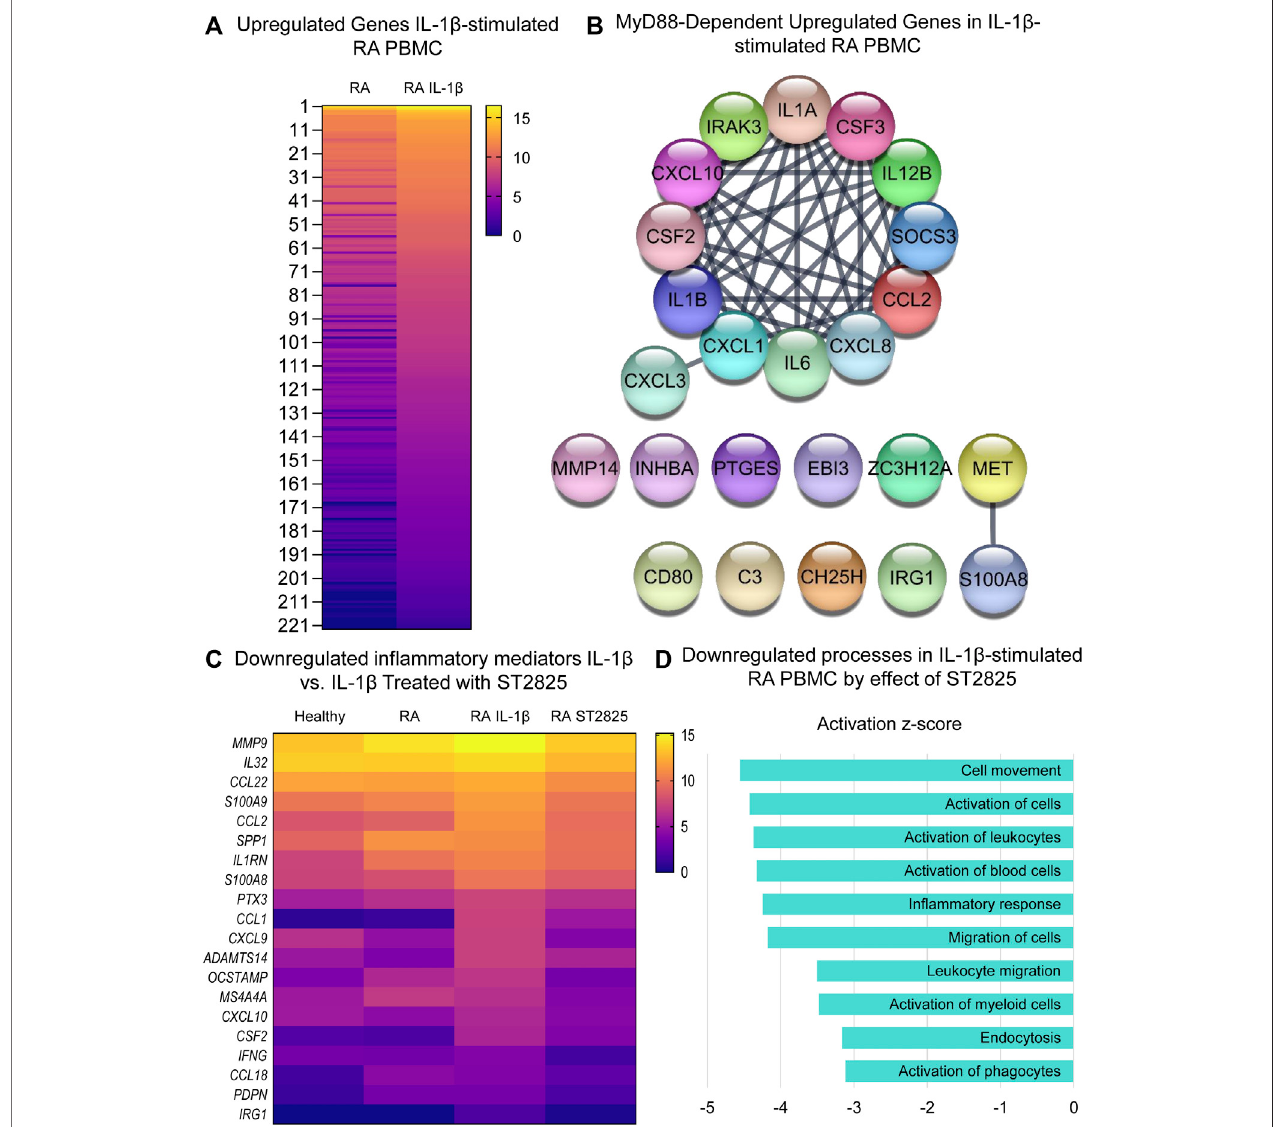
FIGURE 4 | MyD88 inhibition by ST2825 downregulates key in fl ammatory mediators and pathogenic processes in IL-1 β -stimulated PBMC from DMARDs-naïve RA patients. (A) Transcriptomic signatures from RA PBMC and RA IL-1 β -stimulated PBMC are presented in the heatmap (averaged expression patterns of biological replicatesareshown). (B) MyD88-predictedtargetgenenetworkwasidenti fi edfromupregulatedgenesexpressedinRAPBMCvs.RAIL-1 β -stimulatedPBMC. (C) Top 20 downregulated in fl ammatory mediators by effect of ST2825 are exempli fi ed in the heatmap (averaged expression patterns of biological replicates are shown). (D) Top 10 downregulated pathogenic processes were determined based on downregulated genes by effect of ST2825.